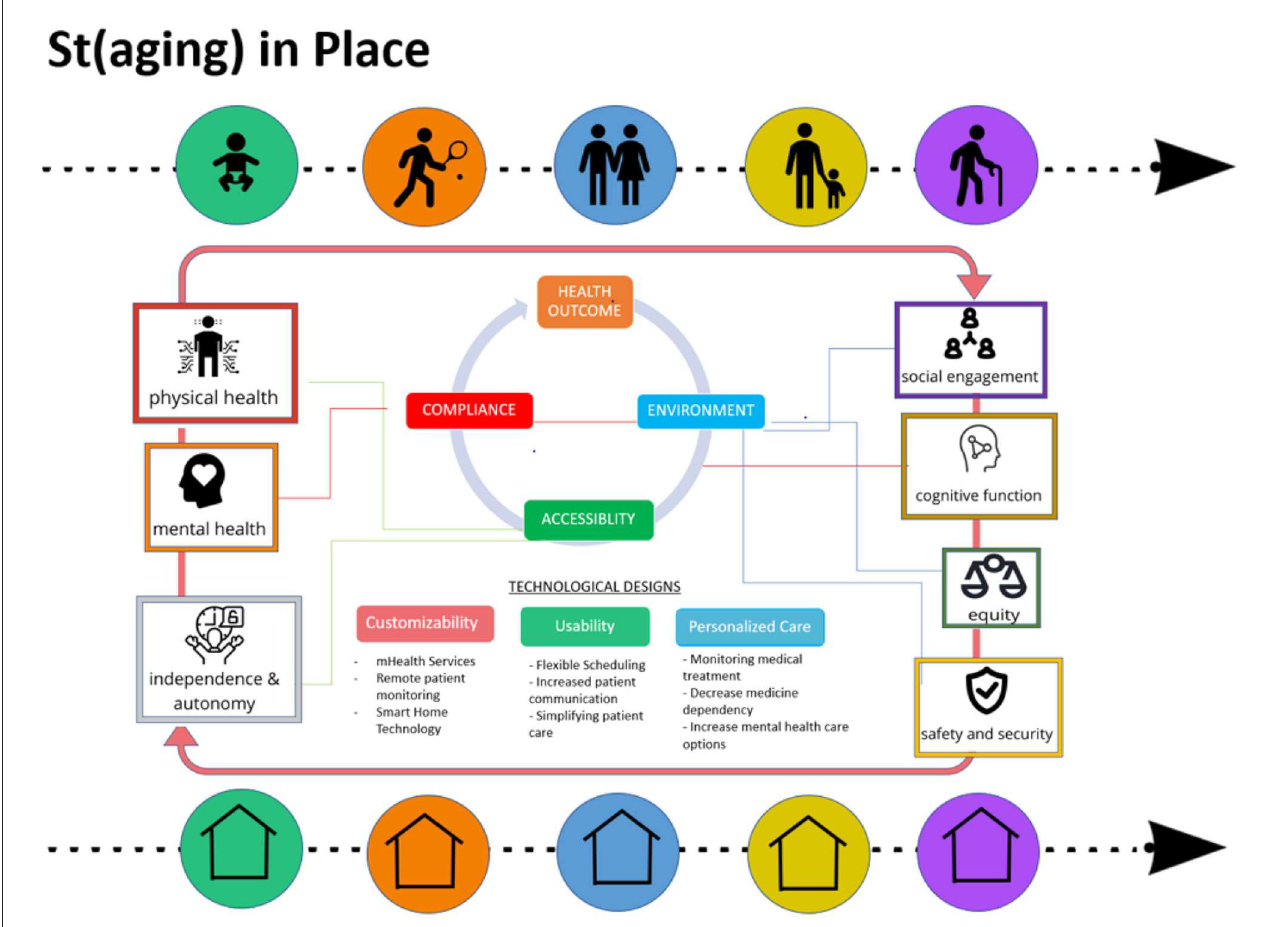
FIGURE1 St(aging)-in-place ICT strategy diagram. The (st)aging in place concept highlights the home environment’s capability to respond to the needs of the individual throughout different life stages in a single residence. The diagram depicts how technological designs support environment, accessibility, and compliance